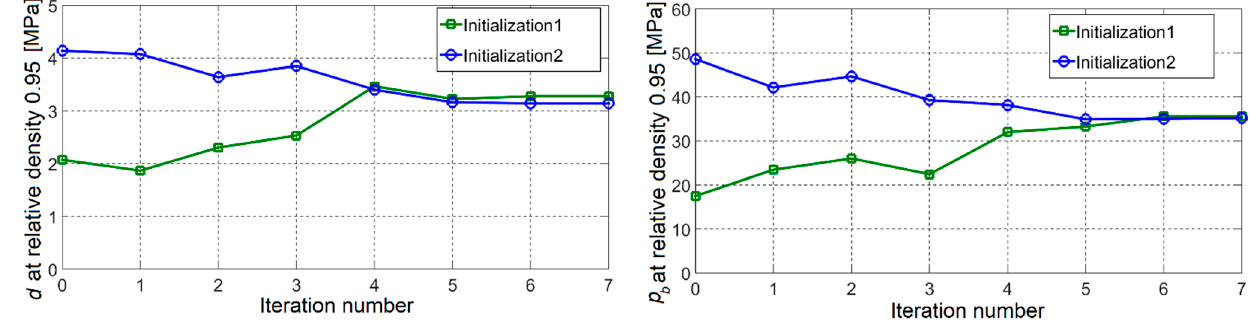
Figure 11. Convergence plots for two selected parameters.